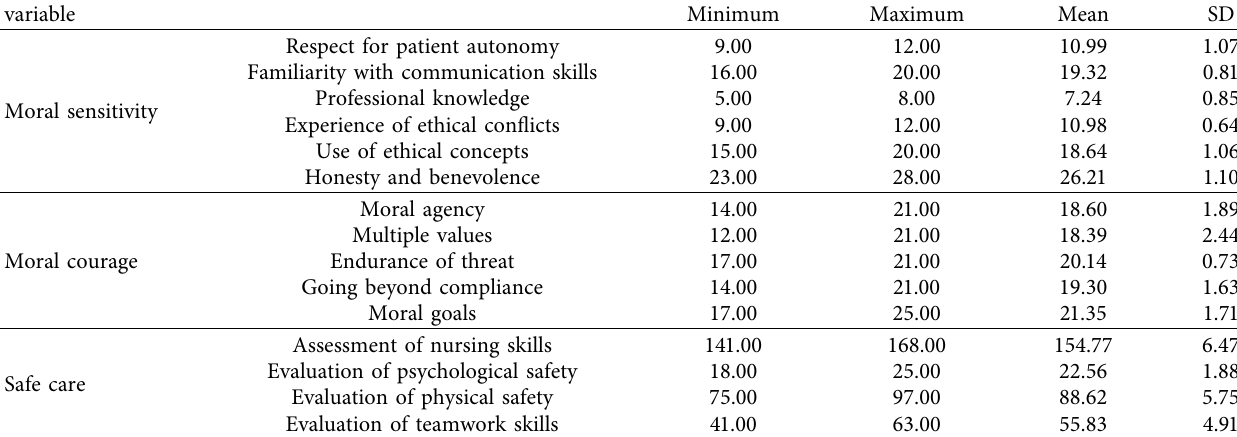
Table 2: Means and standard deviations of the participants’ scores for the domains of moral sensitivity, moral courage, and safe care. variable